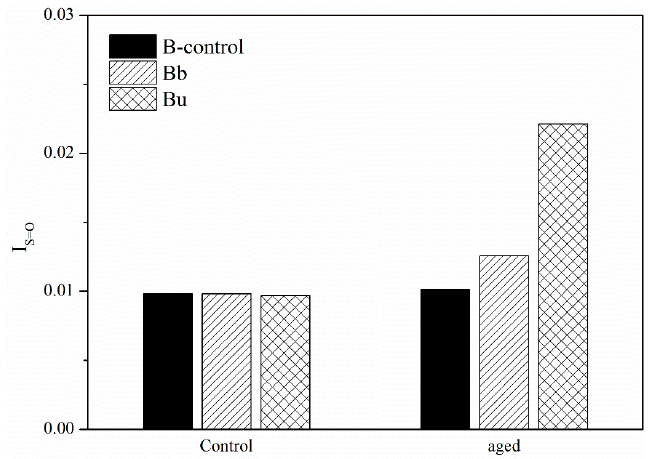
Figure 10. I S=O of the second group before and after UV aging.